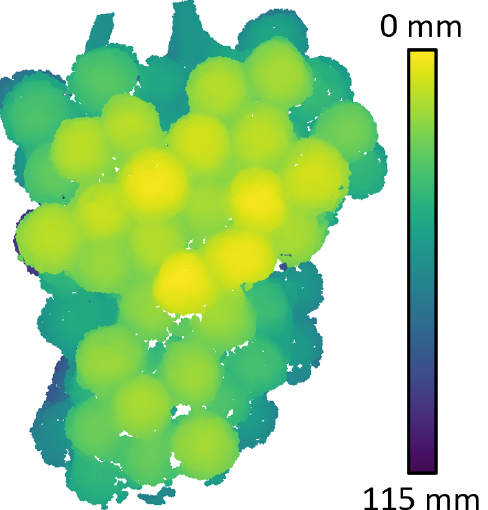
Figure 6. Example photogrammetry 3D depth scan of the grape bunch which was located indoors.